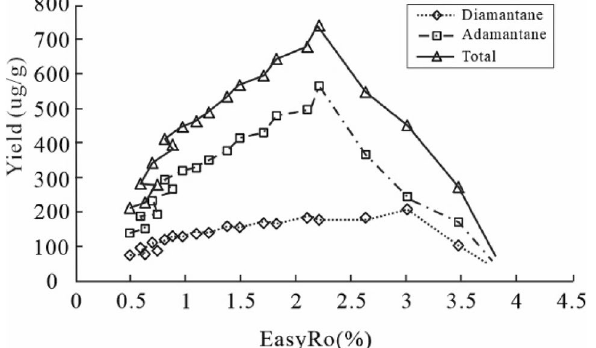
Figure 2. Variation in diamondoids yields (µg/g oil) with EasyRo (%) from hydrothermal pyrolysis of oil. (Total = sum of adamantanes and